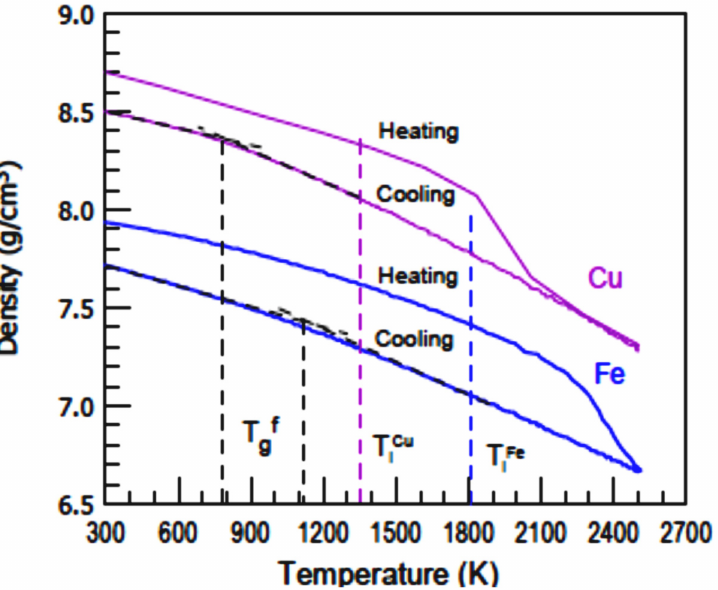
Figure 8. Ag Phase 3 enthalpy coefficient ∆ ε lg ( θ ) = ε ls − ε gs with ε ls0 = ε gs0 = 1.53040 plotted versus − 0.25713, ∆ ε − 0.12648 inducing ∆ ε θ . θ θ nG = nG ) = lg ( T n+ = 1391 K.